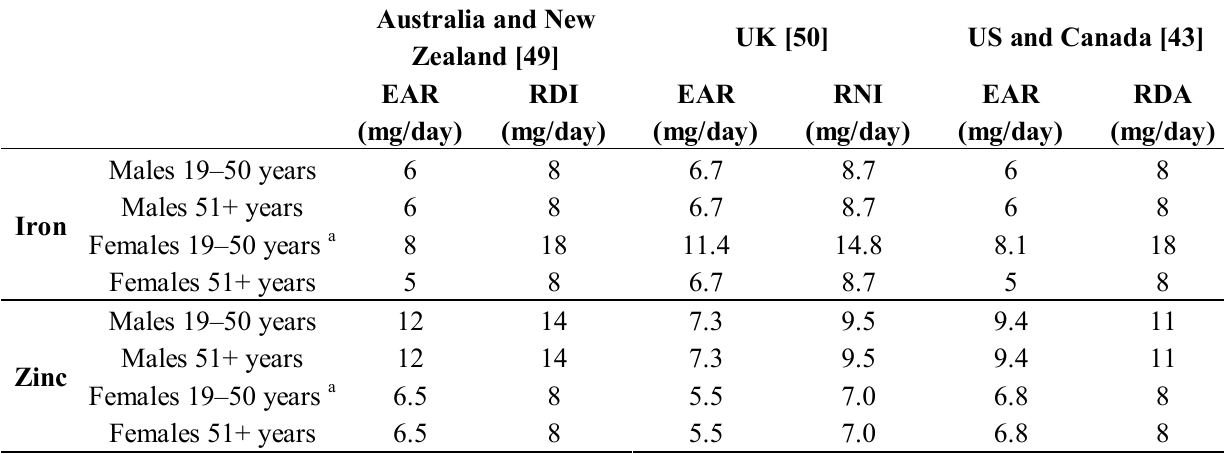
Table 4. Recommended intakes of iron and zinc in Australia and New Zealand, UK, and US and